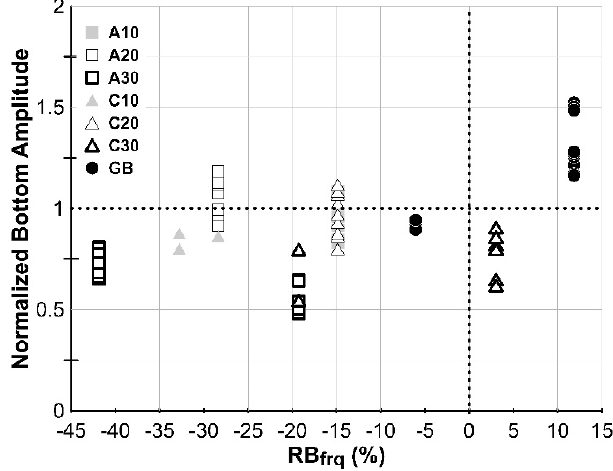
Figure 11. Relationship between the RB frq and the normalized peak amplitude at the frequency close to the thickness–frequency of the composite plate.